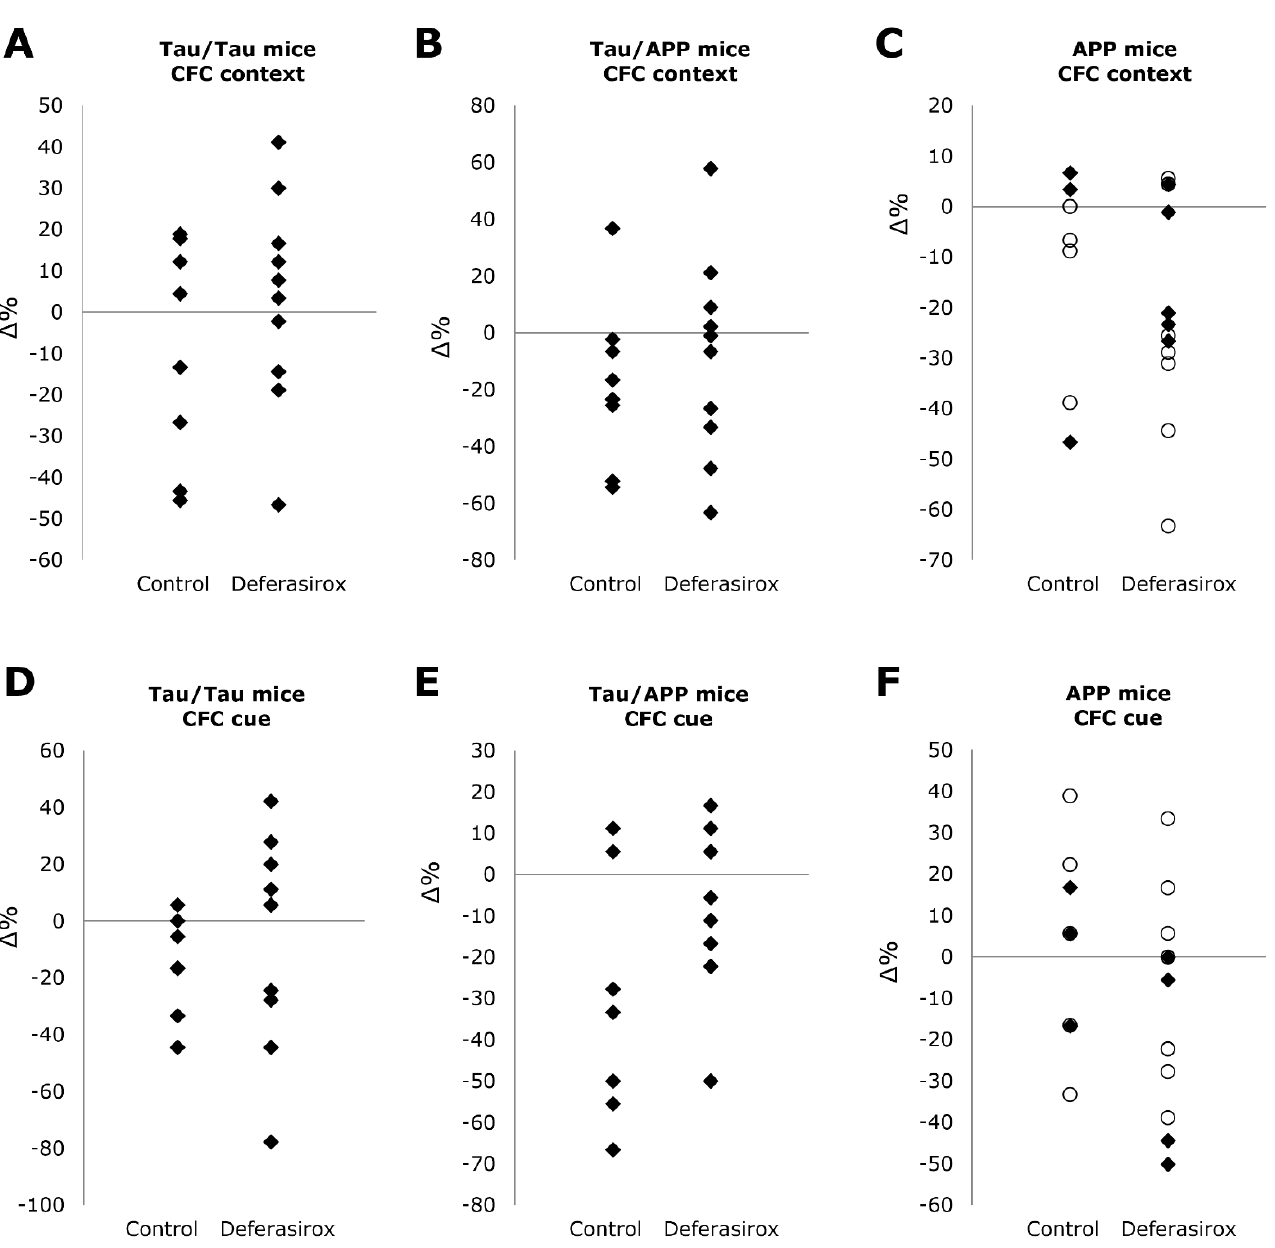
Figure 2. Deferasirox did not significantly affect differences in percentage of time motionless (vertical axis) in contextual fear conditioning (CFC) tests between the start and end of treatment for context (location) in ( A ) Tau/Tau ( p = 0.33), ( B ) Tau/APP ( p = 0.56), or ( C ) APP ( p = 0.43) mice, or for cue (sound) in ( D ) Tau/Tau ( p = 0.47), ( E ) Tau/APP ( p = 0.062), or ( F ) APP ( p = 0.19) mice. Males are black diamonds, and females are white circles. By age 14 months, female Tau/Tau and Tau/APP mice had deteriorated to such a degree that they were unfit for CFC tests, thus only males were studied.